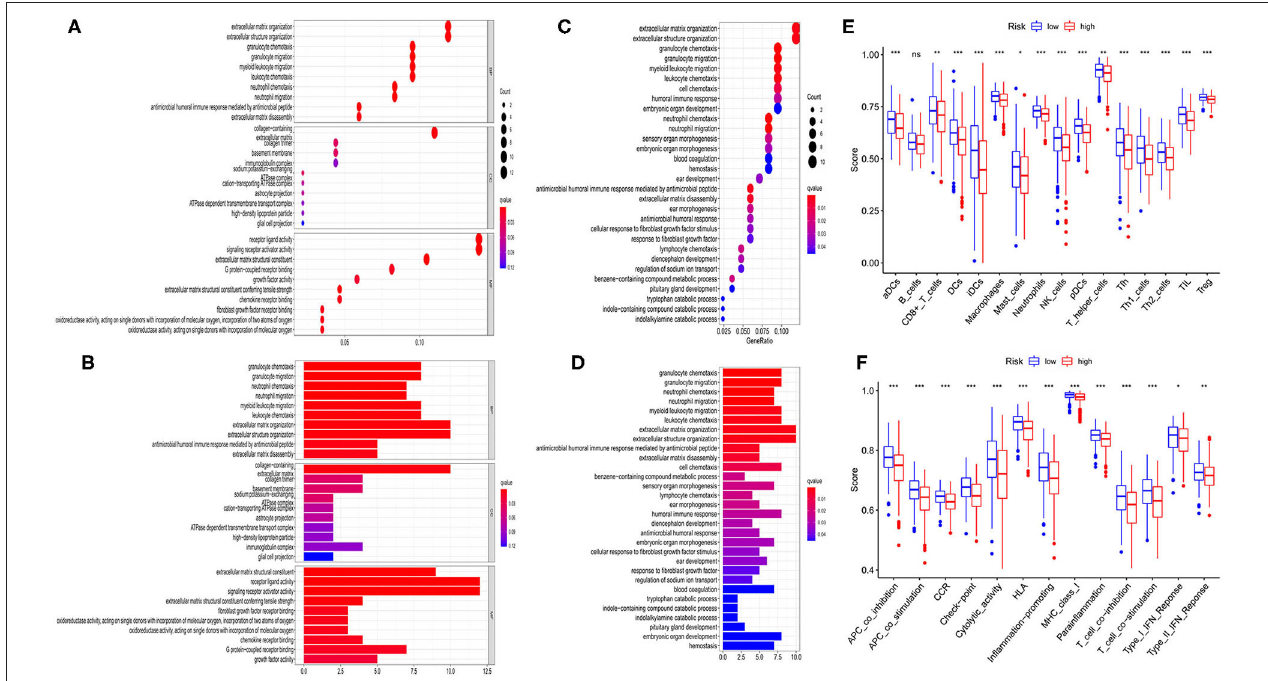
FIGURE 6 | Functional analysis based on the DEGs between the two-risk group in TCGA cohort. (A,B) Bubble and barplot graph for GO enrichment. (C,D) Bubble and barplot graph for KEGG pathways. (E) Comparison of the infiltration of 16 immune cells between low- and high-risk group. (F) Comparison of the immune functions between low- and high-risk